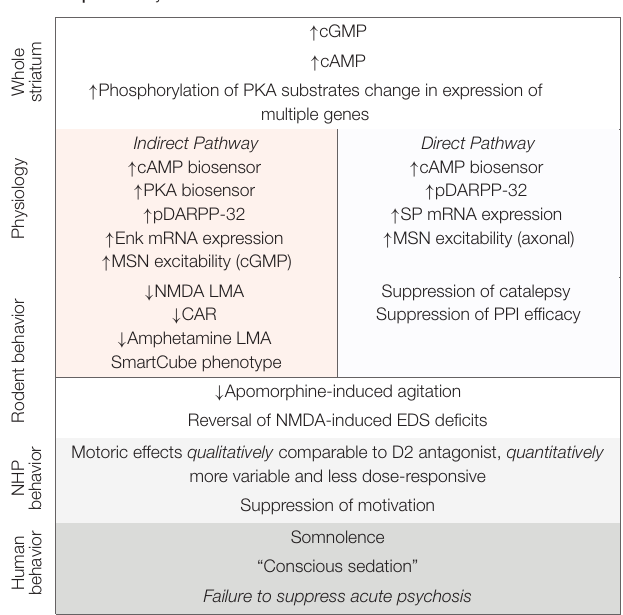
TABLE 1 | Summary of the effects of PDE10A